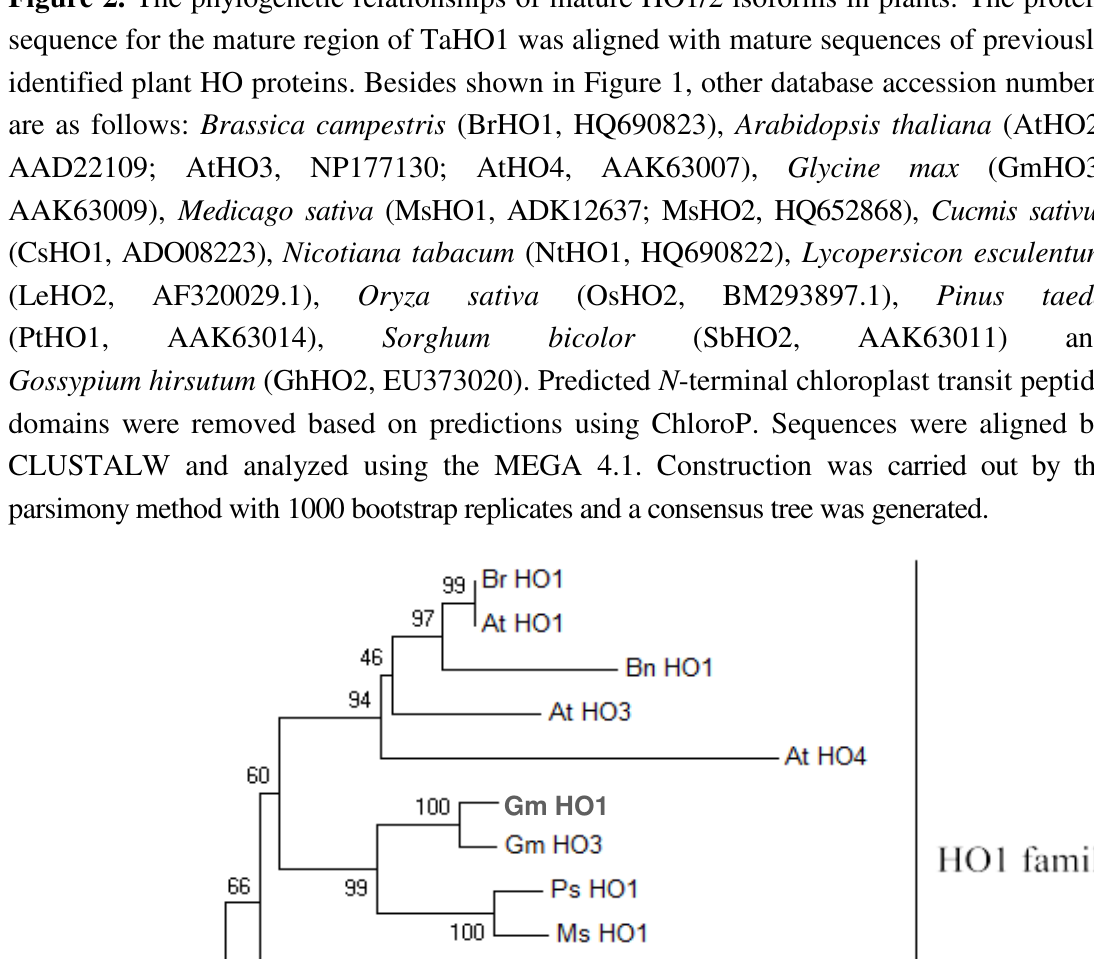
Figure 2. The phylogenetic relationships of mature HO1/2 isoforms in plants. The protein sequence for the mature region of TaHO1 was aligned with mature sequences of